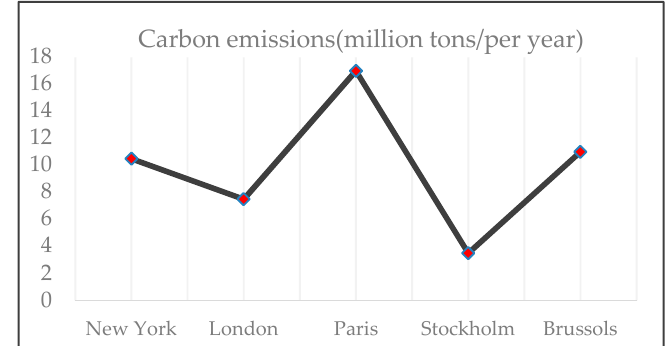
Figure 4. Carbon emissions from passenger transportation of different cities.